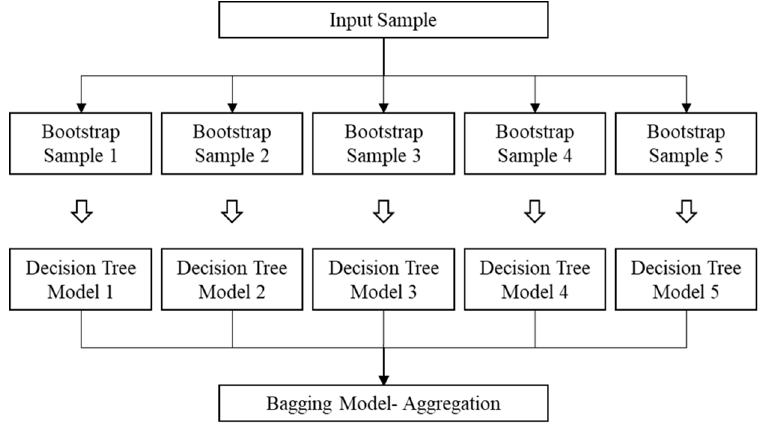
Figure 8. Procedure of the bagging method from an input sample.